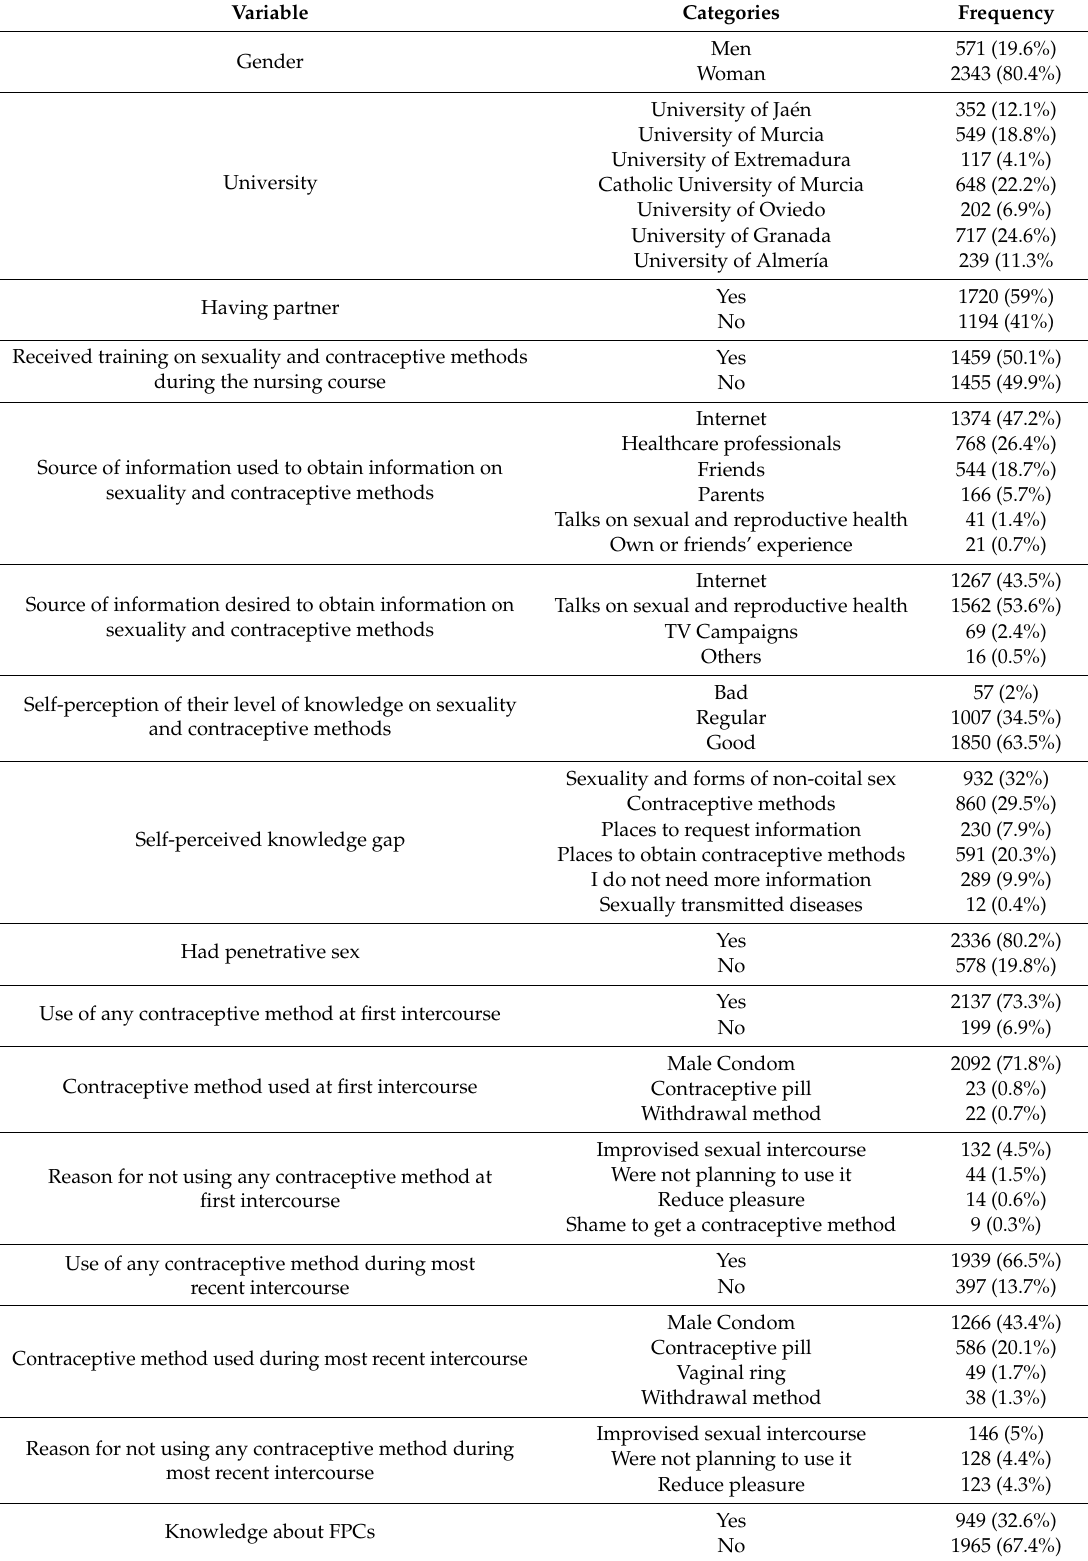
Table 1. Sociodemographic variables of the